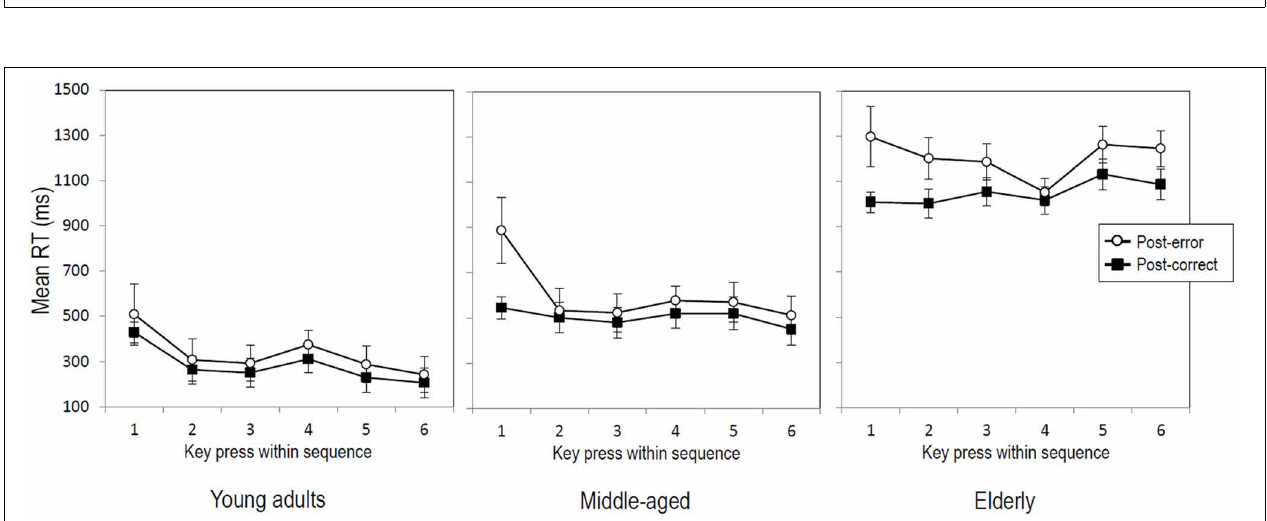
FIGURE 2 | Mean RTs per key press within post-error (open circles) and post-correct (black squares) 6-key sequences as a function of age group. Error bars represent standard errors.